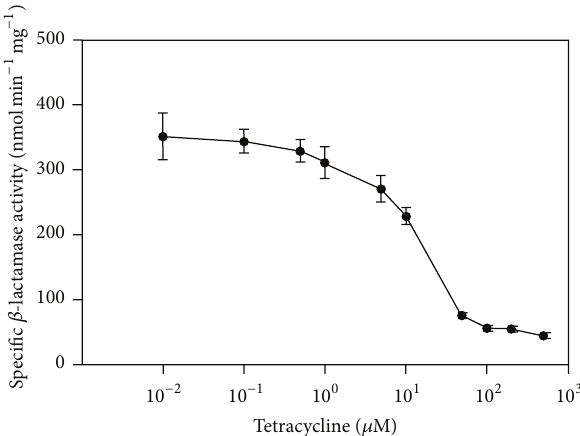
Figure 4: Dose-dependence of tc-RS4-mediated repression of bla mRNA translation. M. acetivorans carrying the mcrB construct on the chromosome was cultivated in the presence of varying amounts of tc before specific Bla activity was